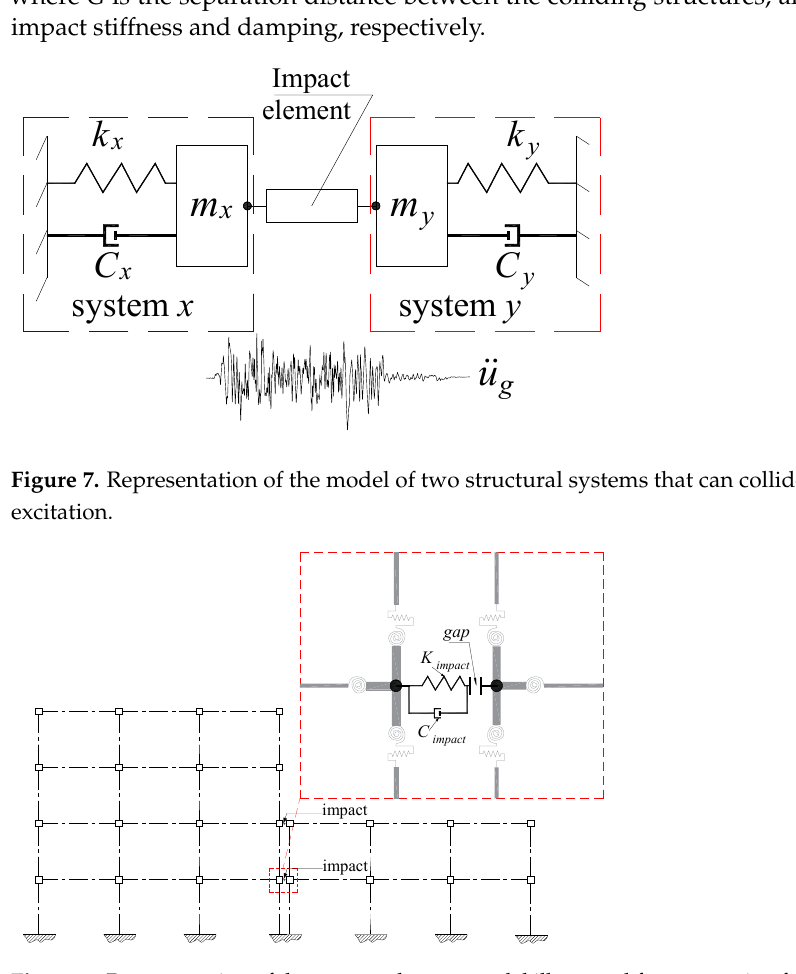
Figure 8. Representation of the contact element model illustrated for a scenario of floor-to-floor im- pact.